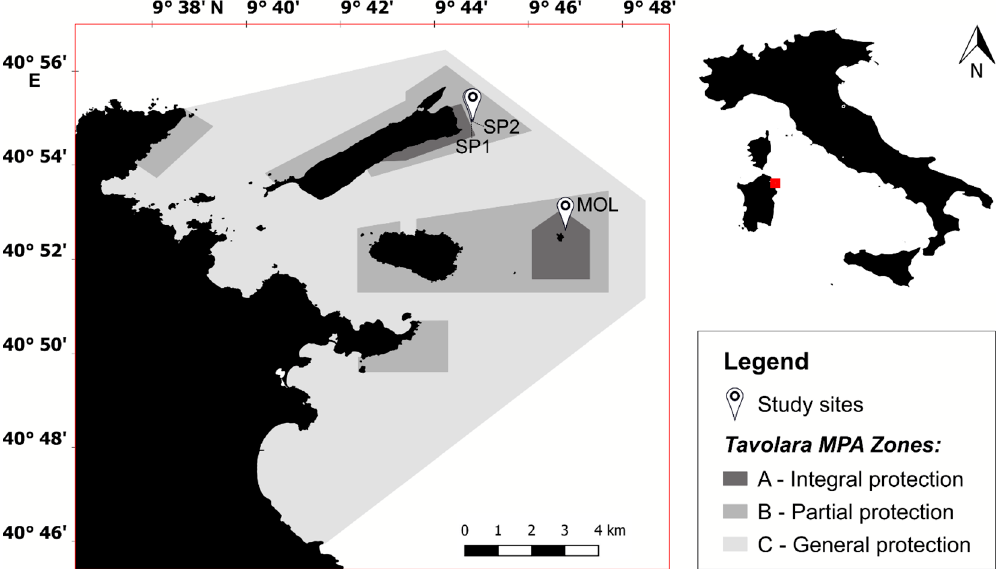
Figure 1. Zonation of Tavolara–Punta Coda Cavallo Marine Protected Area (TPCCMPA). Study sites are indicated: SP1 = Secca Papa 1; SP2 = Secca Papa 2; MOL = Molarotto. Zone A: fully protected (no-take and no-access) zone; Zones B and C: buffer zones where human activities are restricted. In the B zone, only licensed local small-scale fishing and diving are allowed, while in the C zone, regulated fishing is also open to recreational fishing.